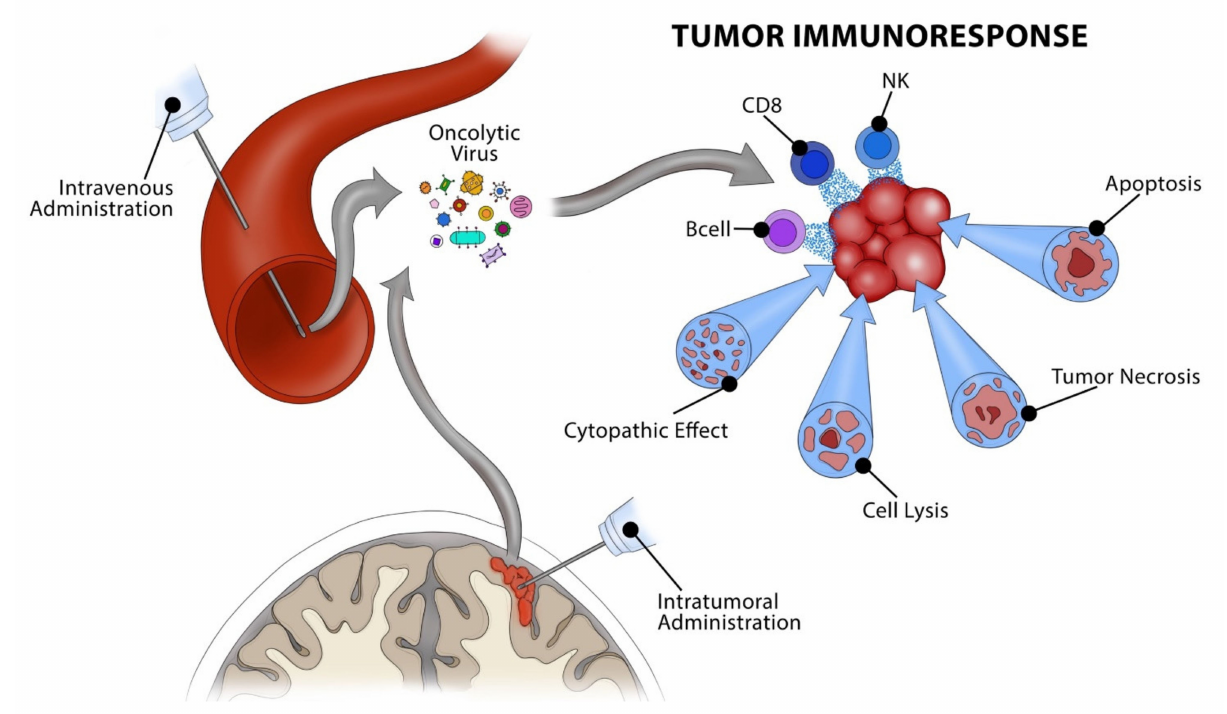
Figure 1. Depiction of oncolytic virotherapy for treatment of brain tumors. Viruses can be administered either systemically through intravenous injection or directly into the tumor or tumor bed status-post resection. Oncolytic viruses preferentially target and selectively infect tumor cells, triggering tumor cell death through a variety of mechanisms including induction of apoptosis, direct cell lysis, or through recruitment of local immune mediators. Artwork courtesy of Roberto C. Suazo, Medical Illustrator and Graphic Design Project Manager for the Department of Neurological Surgery, University of